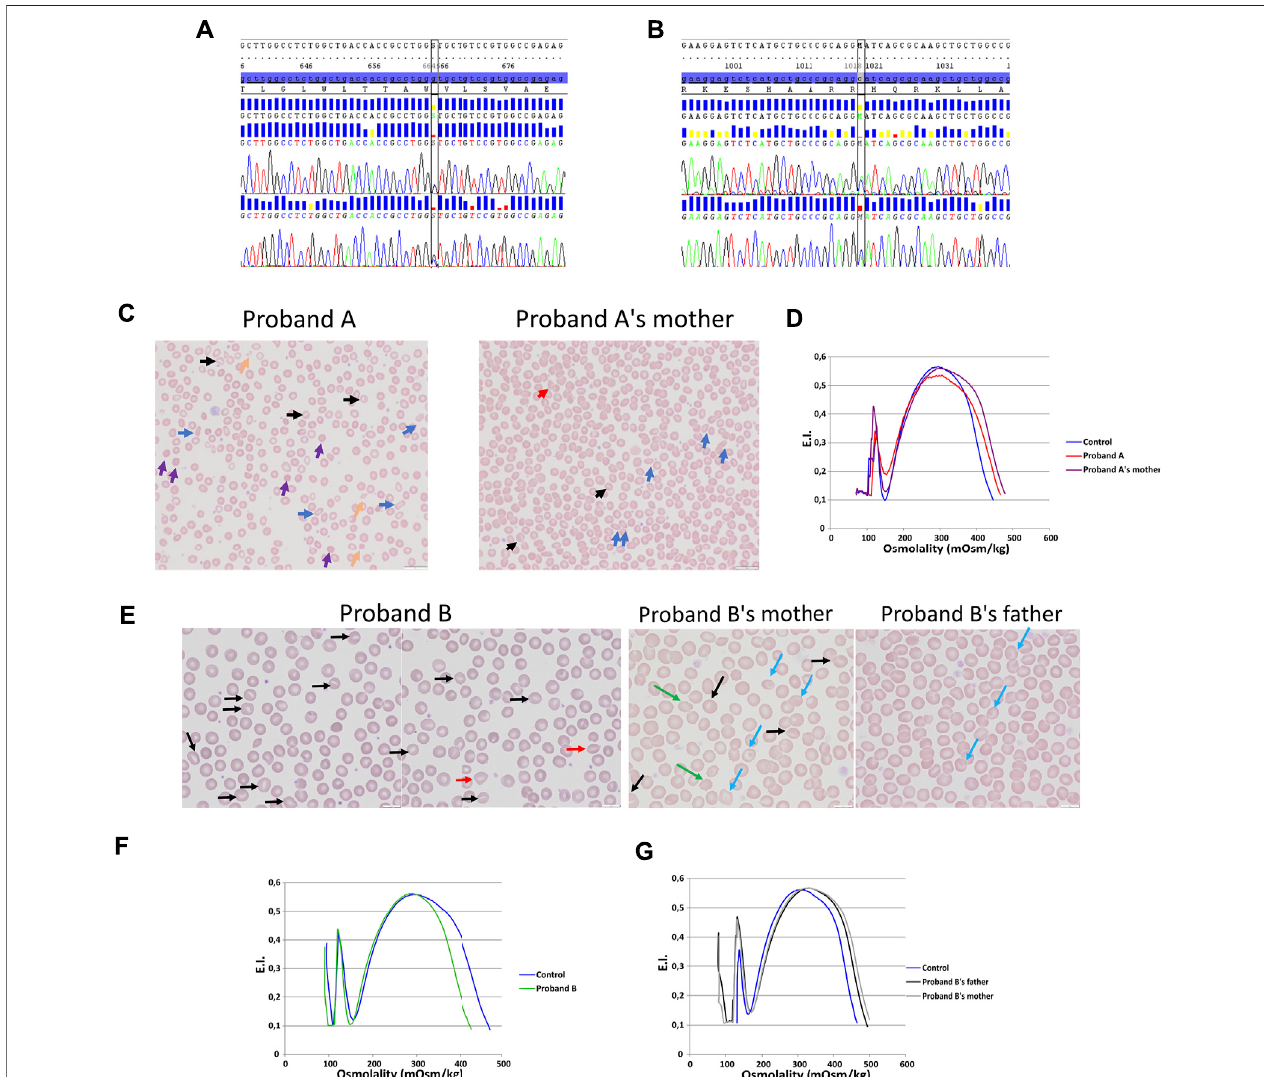
FIGURE 1 | Blood smear, ektacytometry and genetics. DNA sequencing on proband A (A) and proband B (B) . (C) : Blood smear on proband A with her mother (mutation KCNN4 V222L). (D) : Ektacytometry on proband A with her mother and control. (E) : blood smear done on proband B RBC (mutation KCNN4 H340N) and his father and mother. Ektacytometry on proband B (F) and proband B ’ s mother ’ s and father ’ s RBC (G) .